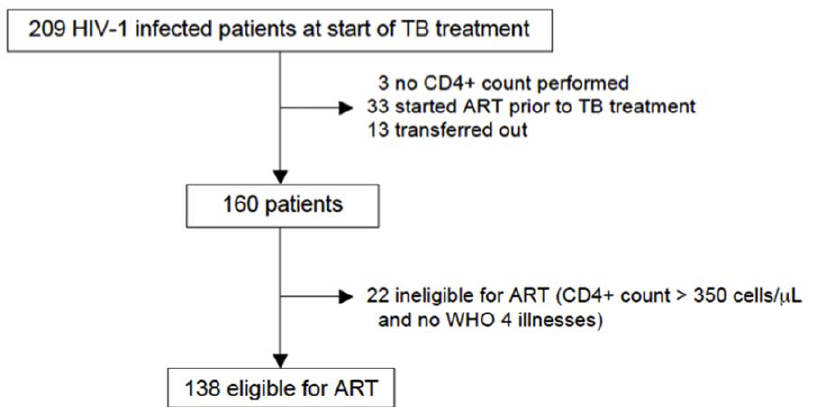
Figure 2. Flow-diagram showing eligible patients according to new South African antiretroviral treatment guidelines [ 25 ] . doi:10.1371/journal.pone.0019484.g002 PLoS ONE |